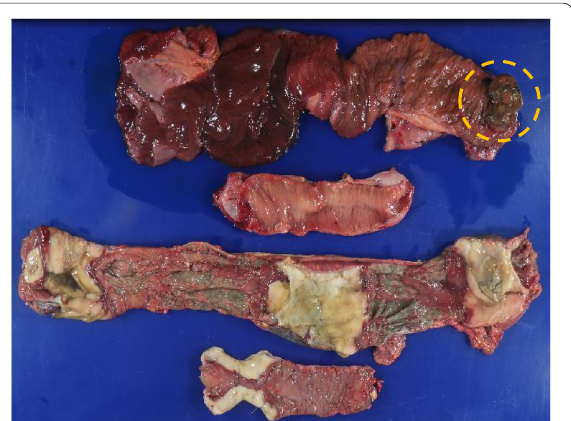
Fig. 3 Findings in the resected specimen. In this figure, the first and second intestinal tracts, from the top, correspond to the resected jejunum and part of the ileum. The small intestinal tumor was found in the oral side of the resected jejunum (circle). The third intestinal tract from the top represents the resected transverse colon and descending colon. The fourth intestinal tract from the top is the resected sigmoid colon. The dark-red colored segments of resected specimens showed ischemic changes. Particularly, the resected white colored segment of colon had multiple necroses with ulceration